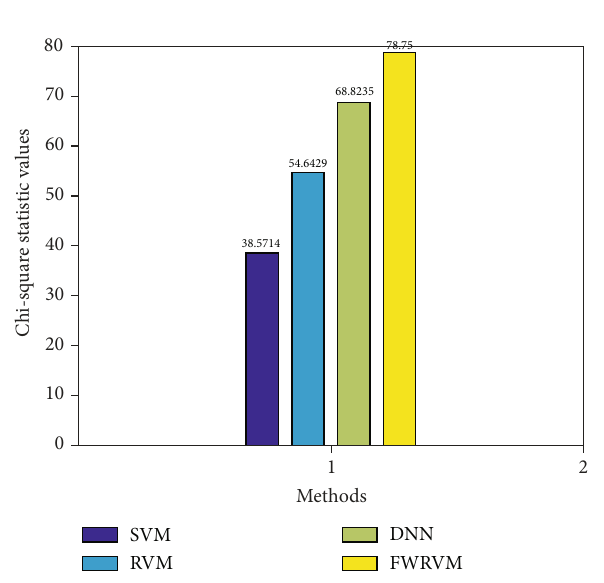
Figure 7: Time comparison.